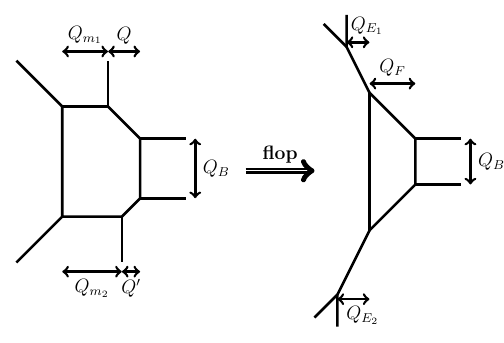
Figure 24 . Two (cid:13)op transitions from the web in (cid:12)gure